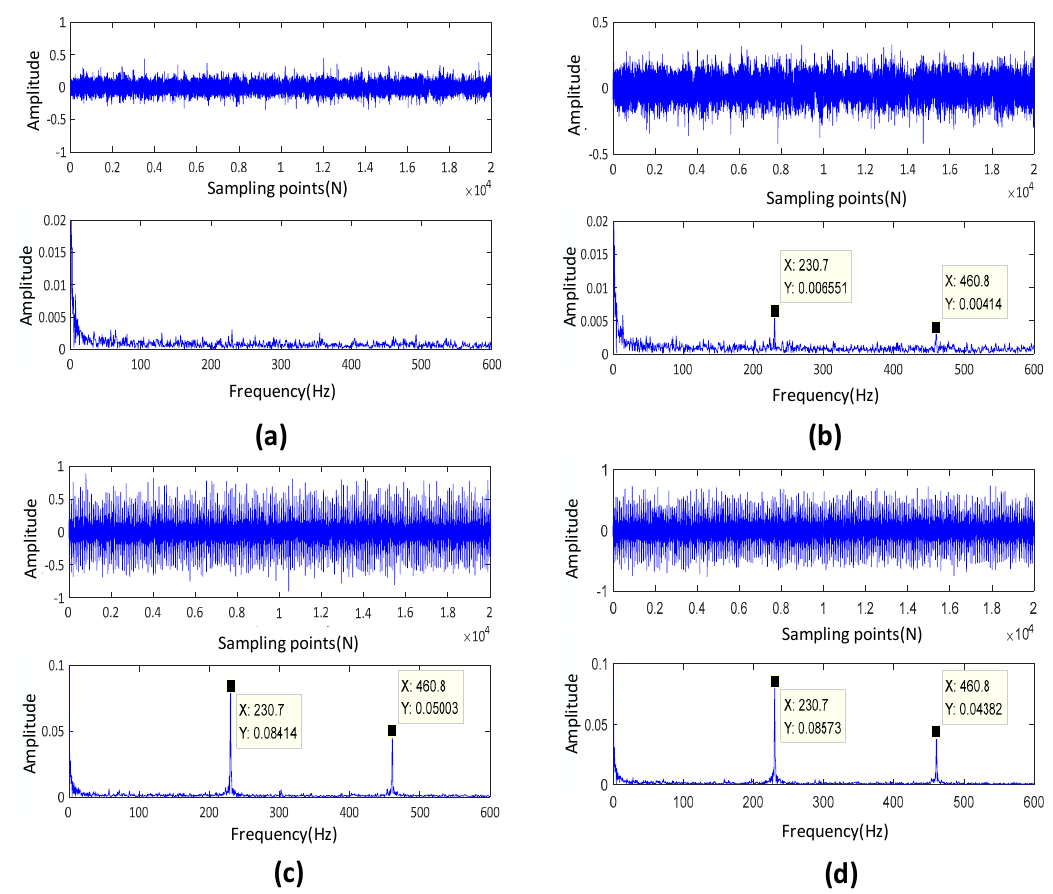
Figure 6. Time domain and envelope analysis of signals at different stages, ( a ) T = 550 min. ( b ) T = 5350 min, ( c ) T = 7040 min, ( b ) T =